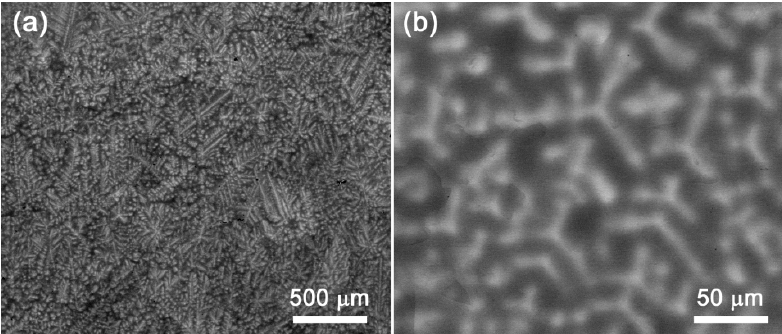
Figure 4. SEM micrographs (back-scattered electrons) of NbTaTiZr alloy annealed at 1200 °C: ( a ) an overview of the microstructure, ( b ) detail taken in higher magnification.